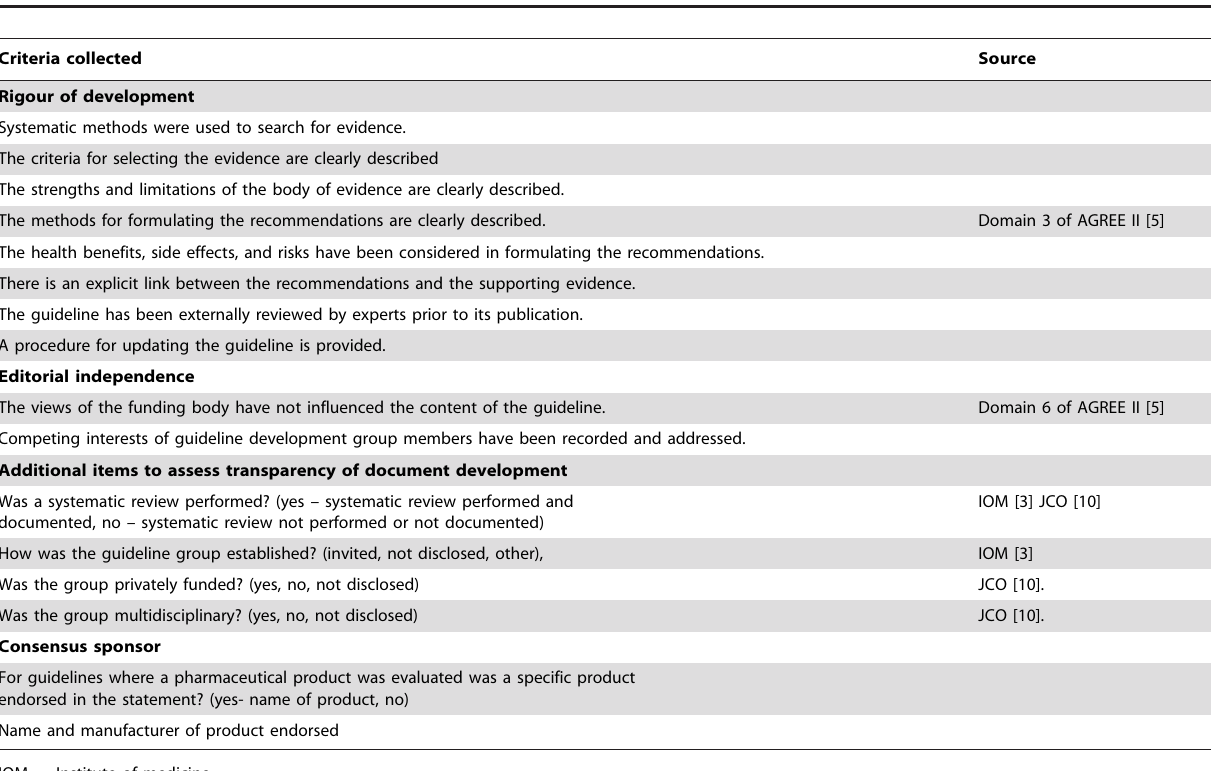
Table 1. Items from AGREE II (Domains 3 and 6) and additional items collected to assess Transparency of Document Development.